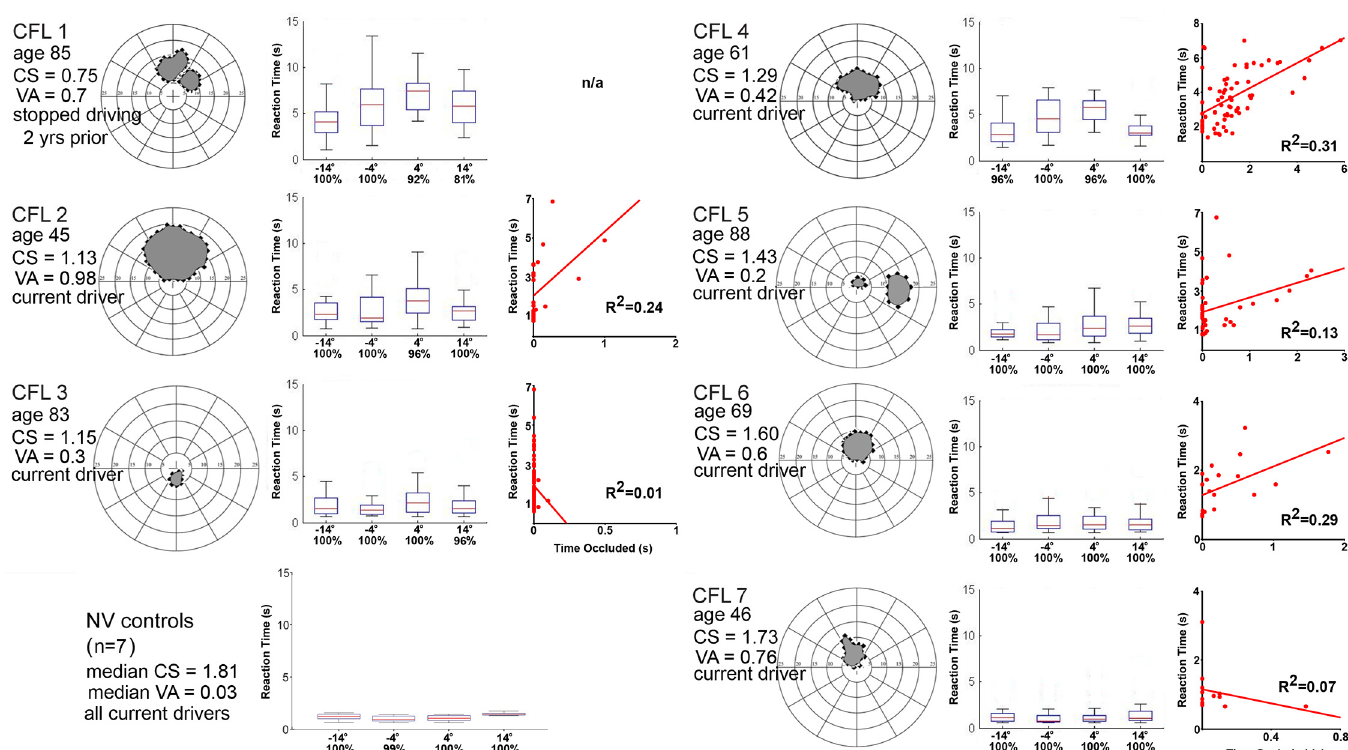
Fig 1. Binocular visual field plots (PRL at origin), Reaction Time (RT) boxplots for Central Field Loss (CFL) subjects (24 – 26 pedestrian appearances at each eccentricity), and individual plots of RT by scotoma occlusion time. RT boxplot for normally-sighted controls is at bottom left. Box lengths show the 25% to 75% interquartile range (IQR) and whiskers show the maximum extent of cases that are not outliers (values > 1.5 times IQR). Detection rates for each eccentricity are below each plot. CFL participant age, binocular contrast sensitivity (CS), binocular visual acuity and driver status are to the left of the plots. CFL5 had a vertical central scotoma and a paracentral lateral scotoma from OS scotoma overlapping OD physiological blind